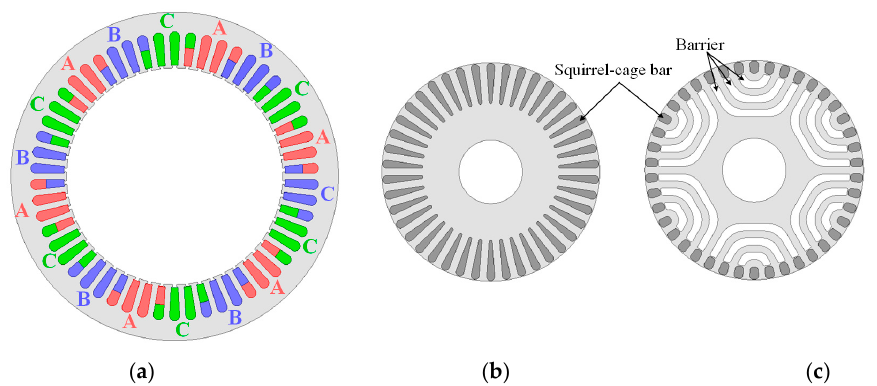
Figure 3. Reference models: ( a ) stator, ( b ) rotor of induction motor (IM), ( c ) rotor of LS-SynRM. Table 1. Specification of reference models.